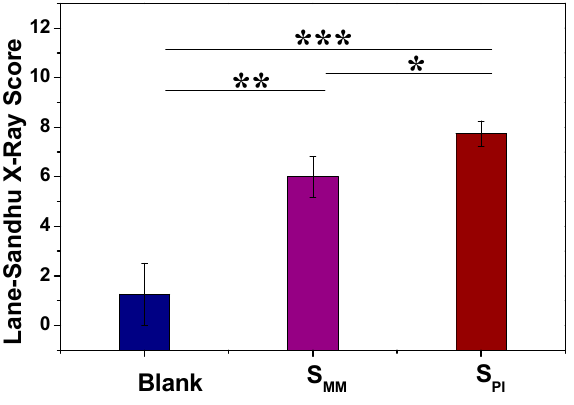
Figure 9. Lane-Sandhu X-ray scores in Blank, S MM , and S PI groups at 12 weeks post-surgery. Data are presented as mean ± SD ( n = 6, * p < 0.05; ** p < 0.01; *** p < 0.001).